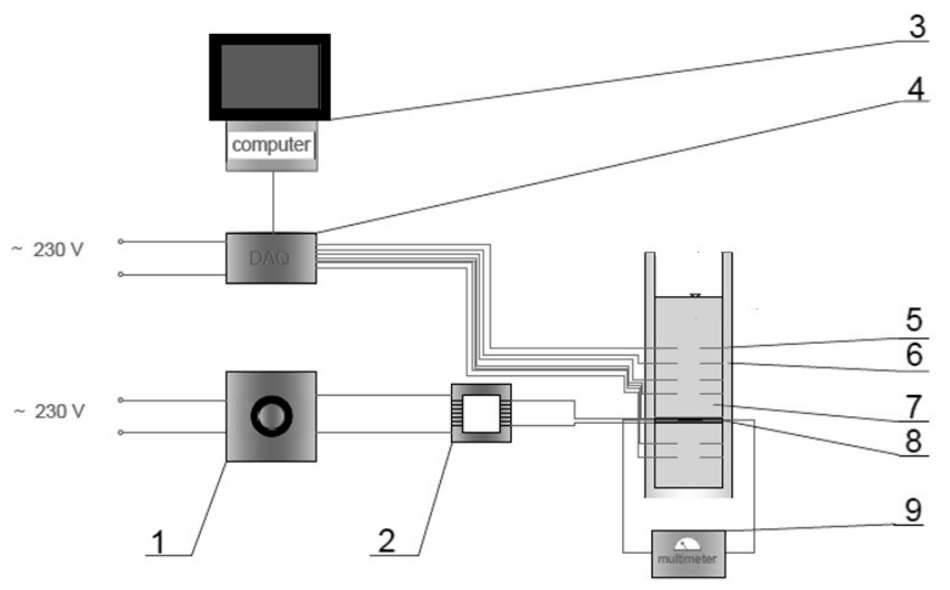
Figure 1. Scheme of the experimental setup: (1) variable transformer, (2) transformer, (3) PC-aided data acquisition system, (4) DAQ-module, (5) Pt100 resistance thermometers, (6) insulation, (7) test vessel, (8) heating section (9) multimeter.